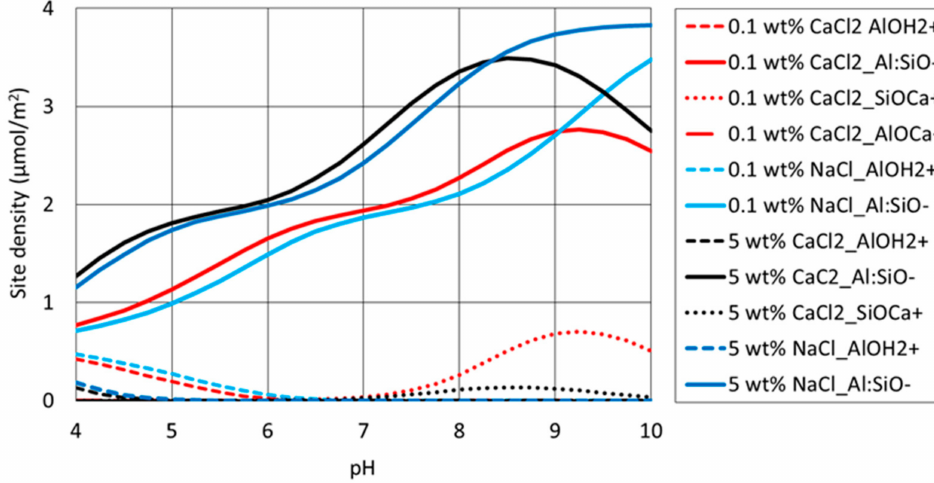
Figure 7. Site density on brine/kaolinite surfaces vs. pH at various ion type and